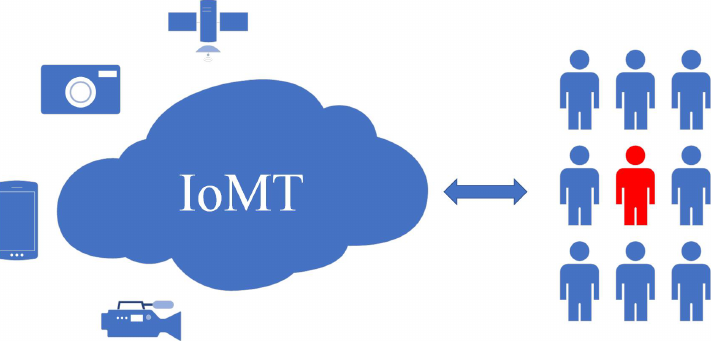
Figure 1. The IoMT collects sensitive private data through sensors (phones, cameras, drones, moni- toring cameras) that might leak personal